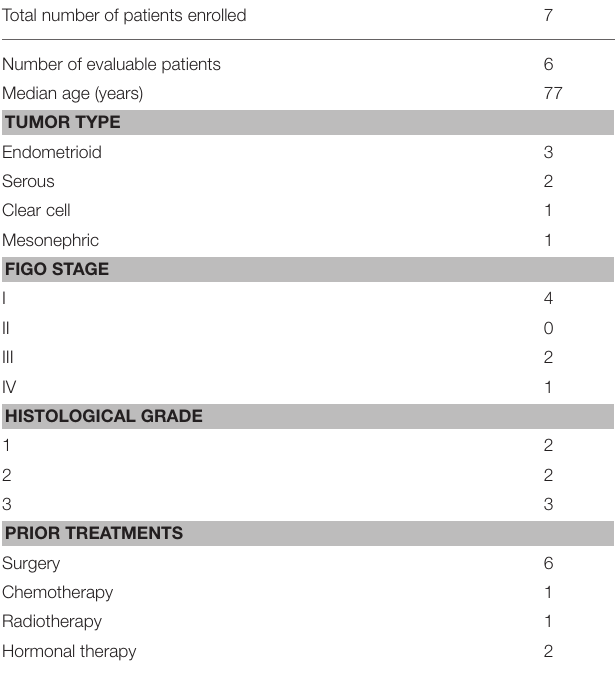
TABLE 2 | Patient